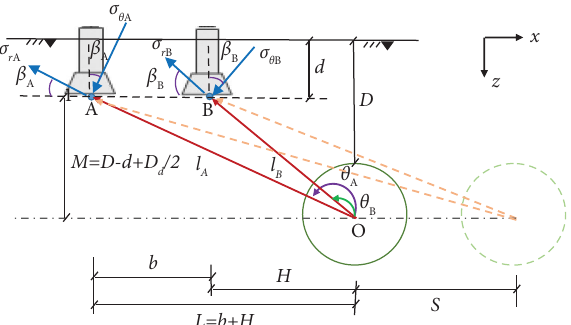
Figure 7: Schematic view of the tangential and radial induced stresses applied to the bottom of tower